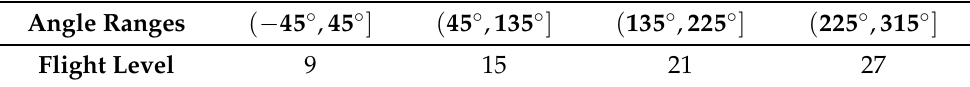
Table 1. Method used to assign flight level according to flight